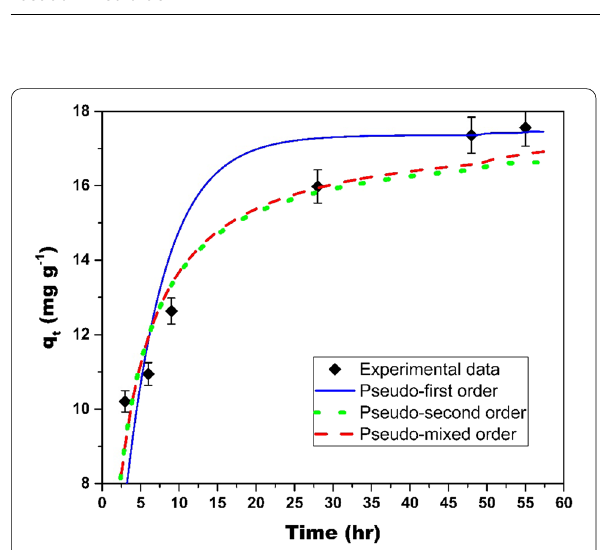
Fig. 6 Plot of adsorption capacity ( q t ) versus time ( t ) for different kinetic models